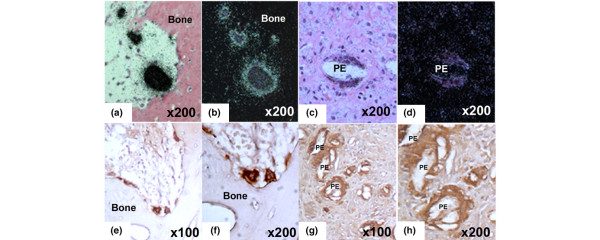
Detection of cathepsin K mRNA and protein in sections of human peri-implantation tissues. The techniques used were in situ hybridization with a 35S-labeled anti-sense RNA probe ((a, c) bright field and (b, d) dark field) and (e-h) immunohistochemistry with a rabbit polyclonal antibody to human cathepsin K. Multinuclear cells on the bone surface and some mononuclear cells in the peri-implant tissues adjacent to the bone express high levels of cathepsin K mRNA (panels a [bright field] and b [dark field]). Low levels of cathepsin K mRNA were detected in multinuclear cells associated with polyethylene (PE) particles (panels c [bright field] and d [dark field]). Multinuclear cells on the bone surface (panels e and f) and mononuclear and multinuclear cells associated with PE particles (panels g and h) stain positively for cathepsin K protein. PE particles are easily identified by their strong bi-refringence with polarizing light microscopy.